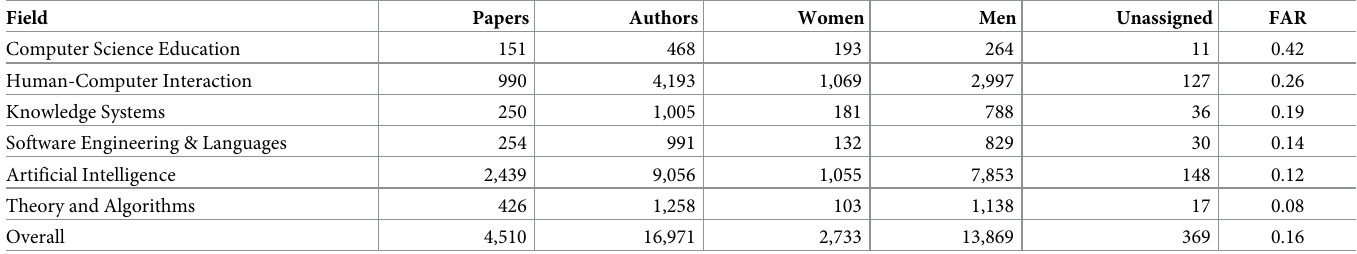
Table 2. Sampled set of non-systems CS conferences, categorized broadly into six fields, including number of accepted papers, total authors (nonunique), authors by gender, and ratio of female authors (sorting order). Gender data comes from generizer.io when at least 90% accuracy of prediction or manual Web search otherwise. The ratio of women among authors (FAR) excludes unassigned